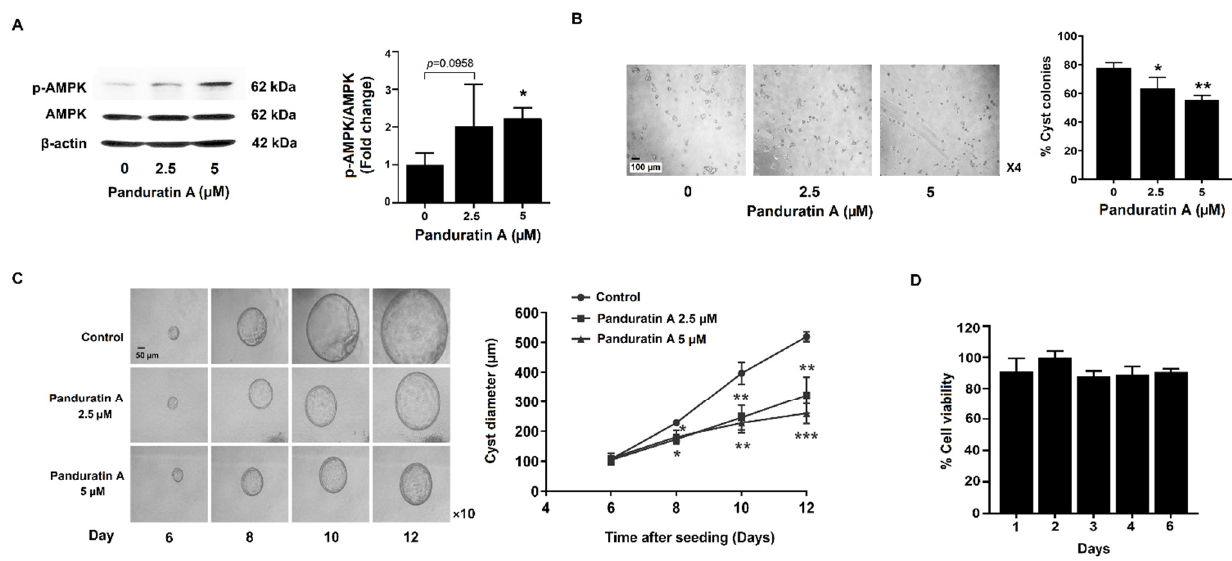
Figure 1. Effect of panduratin A on cystogenesis in MDCK cell–derived cyst model. ( A ) Activation of AMPK in MDCK cells following treatment with panduratin A for 24 h ( n = 5). ( B , C ) MDCK cell–derived cyst colonies ( B ) and cyst growth ( C ) in response to panduratin A. ( C ) Representative micrographs show the same MDCK cysts after exposure to vehicle or 2.5 and 5 µ M panduratin A (>20 cysts analyzed/time point). ( D ) Cell viability following treatment with 5 µ M panduratin A. Data of ( B – D ) are shown as the mean ± SD of 3 independent experiments. * p < 0.05, ** p < 0.01, and *** p < 0.001 compared to control.